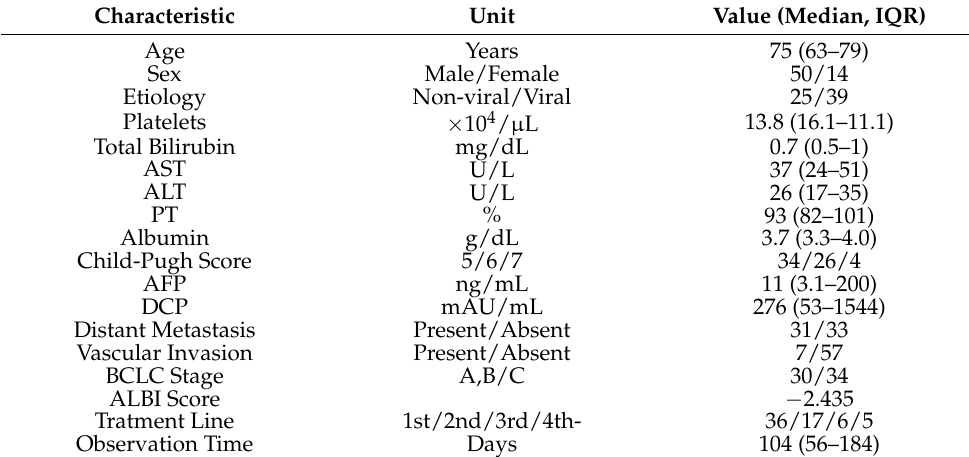
Table 2. Patient characteristics ( N = 64).